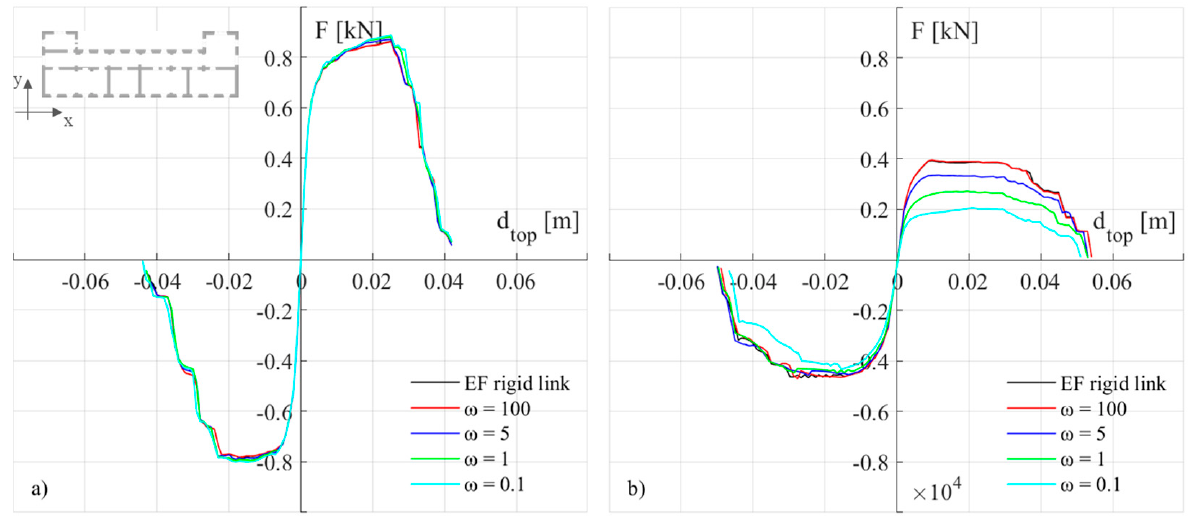
Figure 23. Sensitivity of pushover curves in X ( a ) and Y ( b ) directions varying ω values in the case of Pizzoli’s town